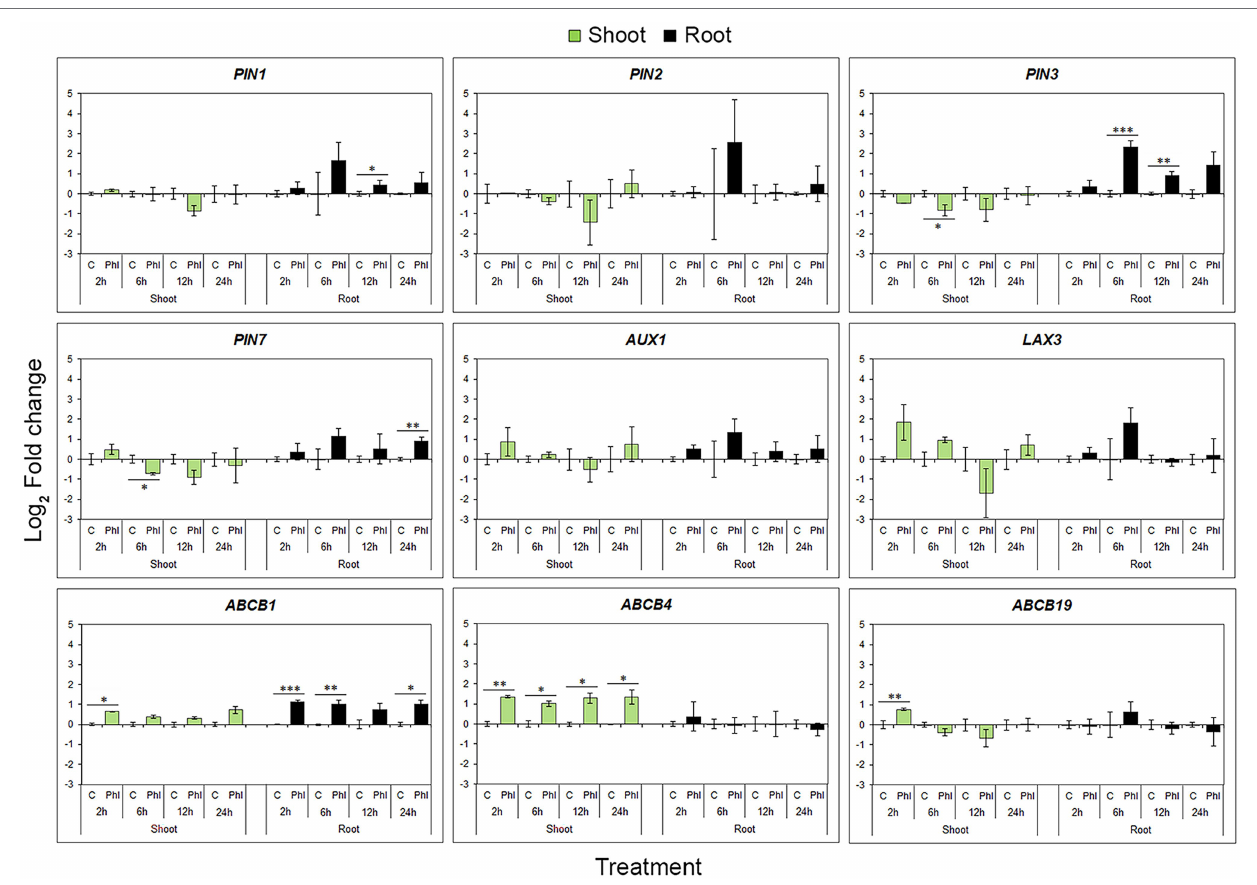
FIGURE 8 | Effect of phloretin on the expression of genes involved in polar auxin transport in Arabidopsis. Expression levels of PIN1, PIN2, PIN3, PIN7, AUX1, LAX3, ABCB1, ABCB4 and ABCB19 genes in Arabidopsis [ Arabidopsis thaliana (L.) Heynh.] Col-0 shoots and roots at 2, 6, 12 and 24 h of treatment with 500 μ M phloretin. Expression levels were calculated relative to an expression of corresponding control according to the ΔΔ Ct method and presented as log 2 transformation of fold changes. Presented data are means ± SE from three biological replicates (samples from independent experiments). Asterisks indicate statistically significant difference at * p < 0.1; ** p < 0.05 and *** p < 0.01 based on Student’s t